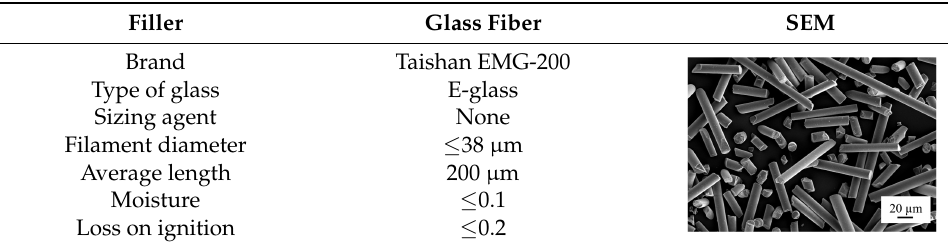
Table 1. Milled glass fiber. Filler